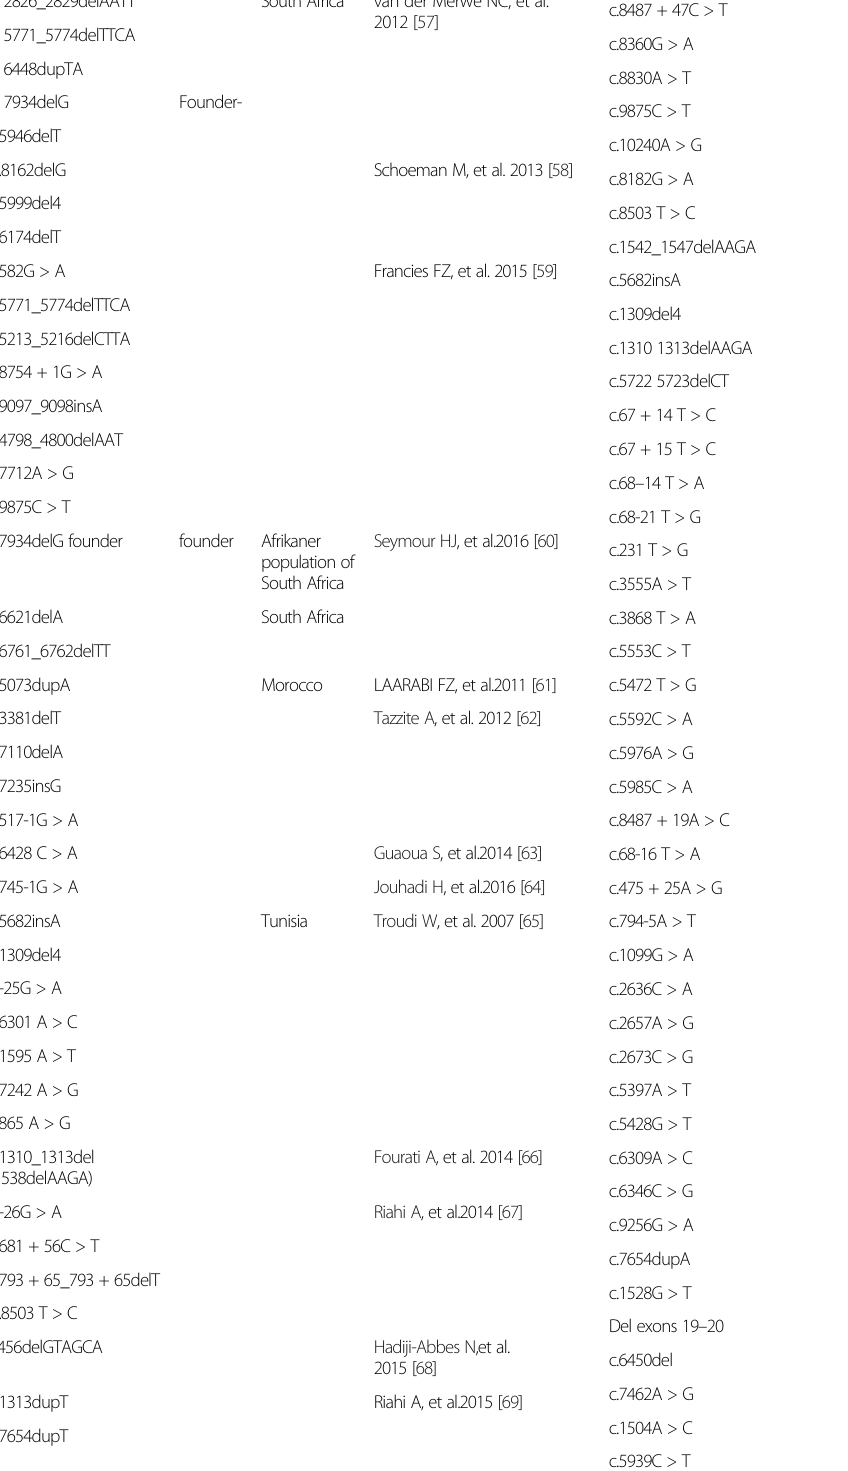
Table 7 Most of the BRCA2 mutations variants detected within African literature